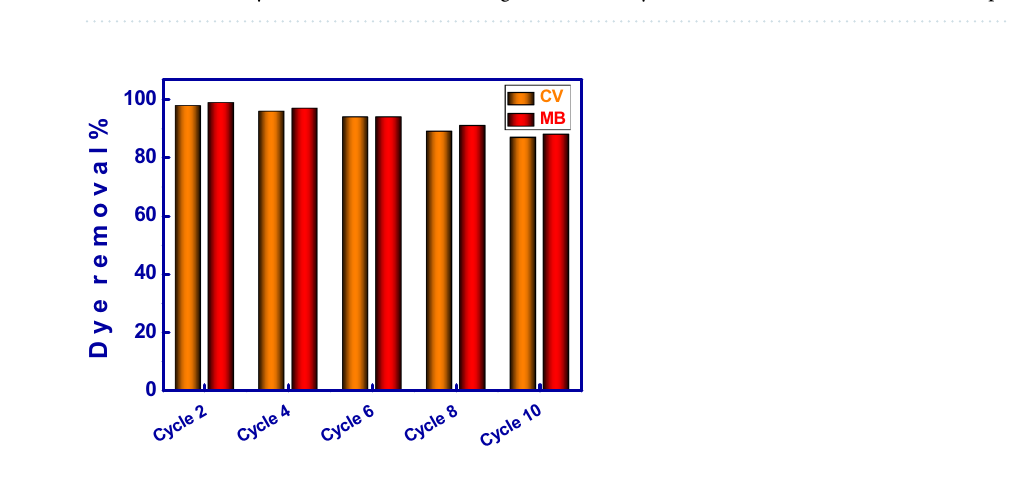
Table 4. Thermodynamic factors for removing MB and CV dyes onto MMT-mAmCs at various temperatures.